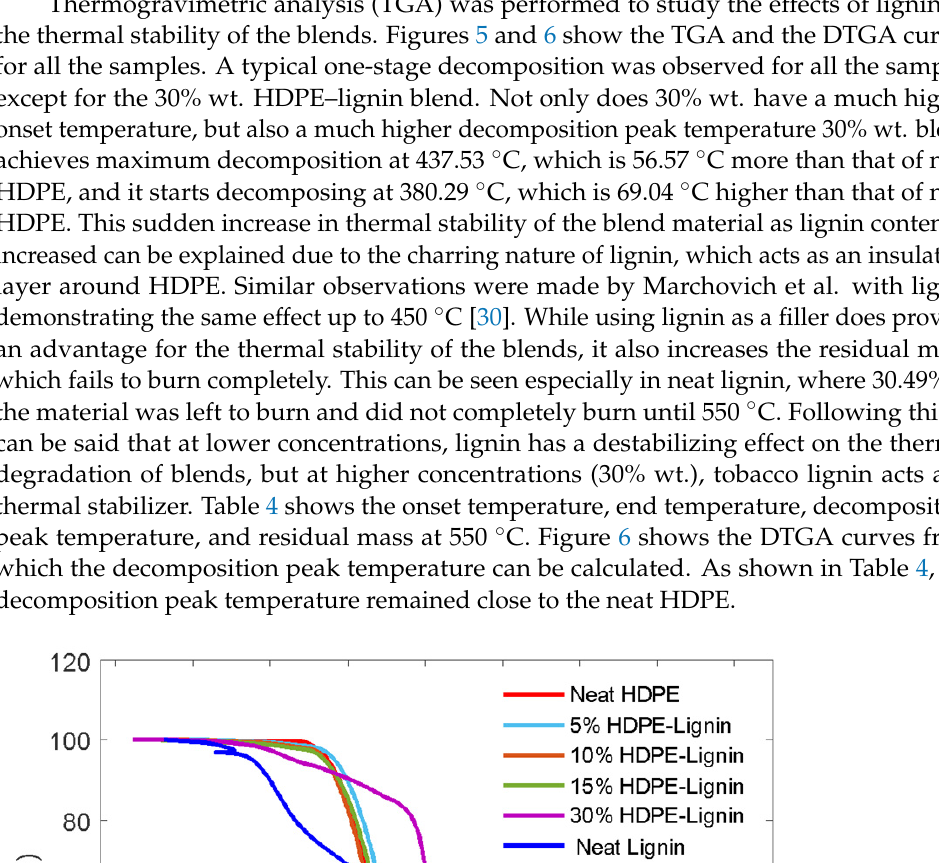
) Figure 6. DTGA curves of different blends of HDPE and lignin. D e r i v e . W e i gh t d ( W e i gh t ) / d ( T